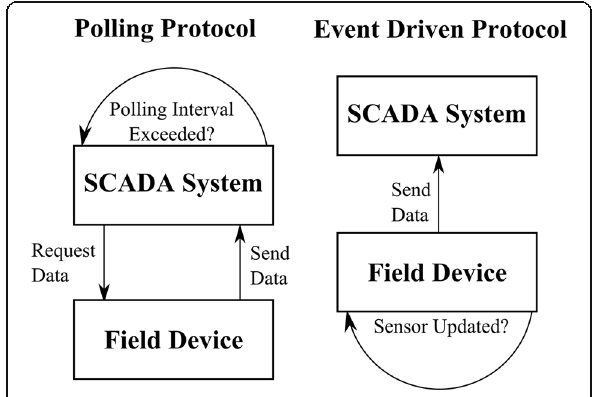
Fig. 4 Polling vs. Event Driven